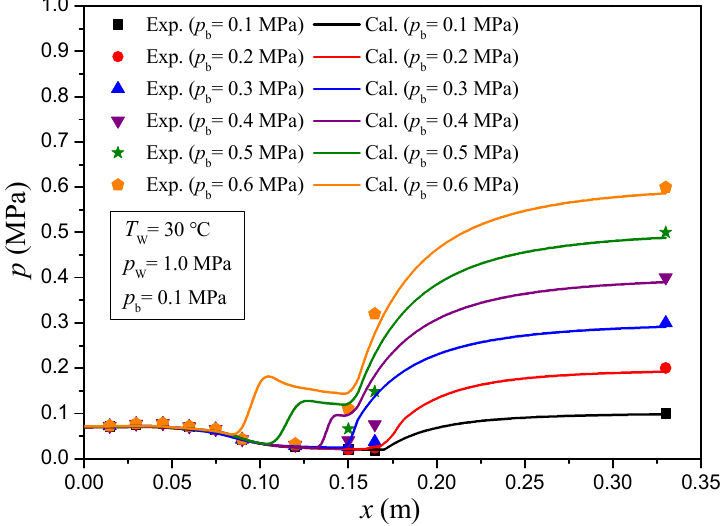
Figure 10. Pressure comparisons for different back pressures.